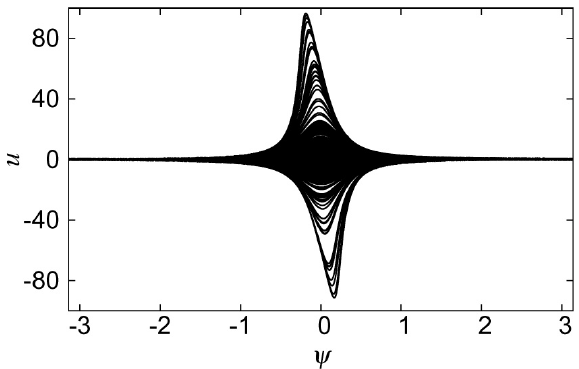
Fig. 15. Phase space for dissipative map (135) with Q = 0 . 4 and α = 8 × 10 − 6